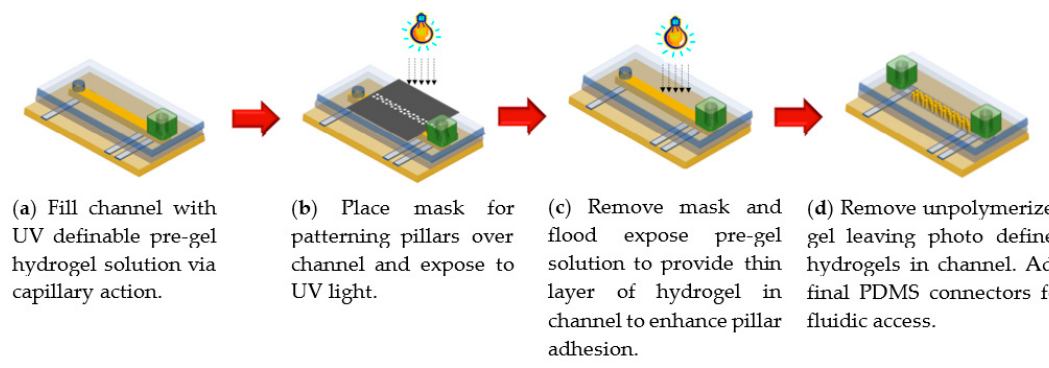
Figure 2. Patterning of hydrogel pillars in microfluidic channel.